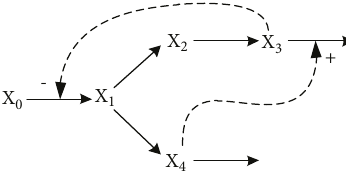
Figure 4: Genetic branch pathways